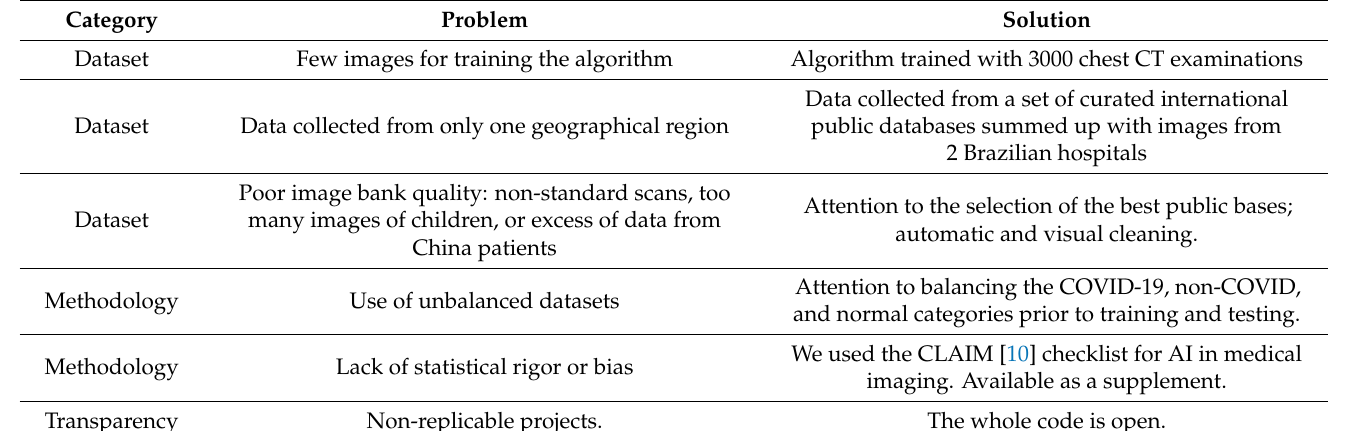
Table 1. Assessment of the main problems found in the literature